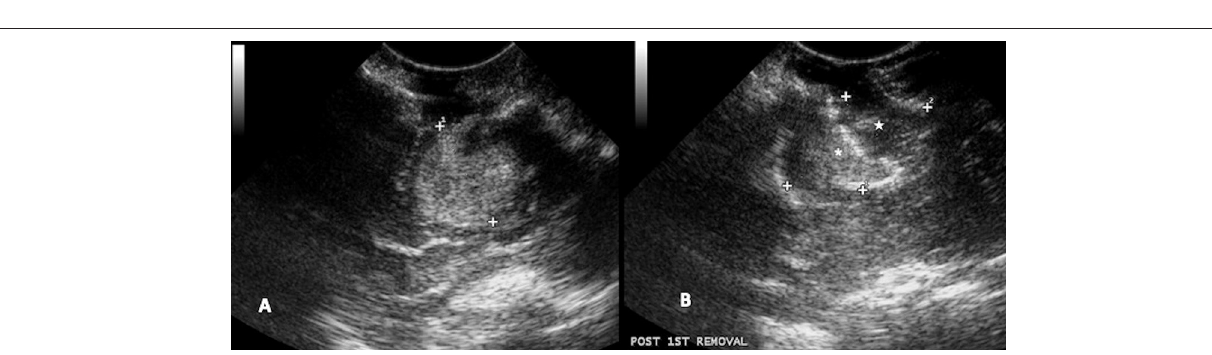
Frontiers in Veterinary Science |